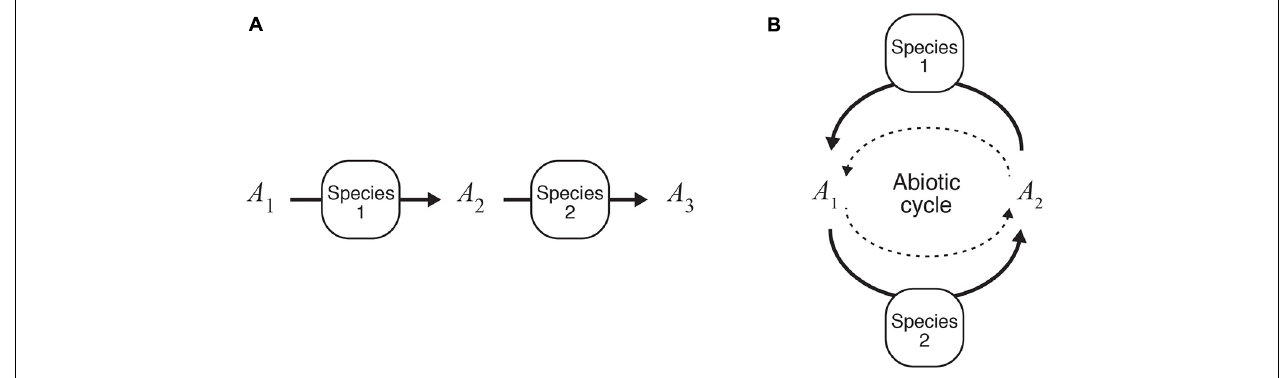
FIGURE 3 | Mutualistic catabolic interactions. (A) One-way interactions (Seto and Iwasa, 2019b). (B) Recycling interactions (Seto and Iwasa,